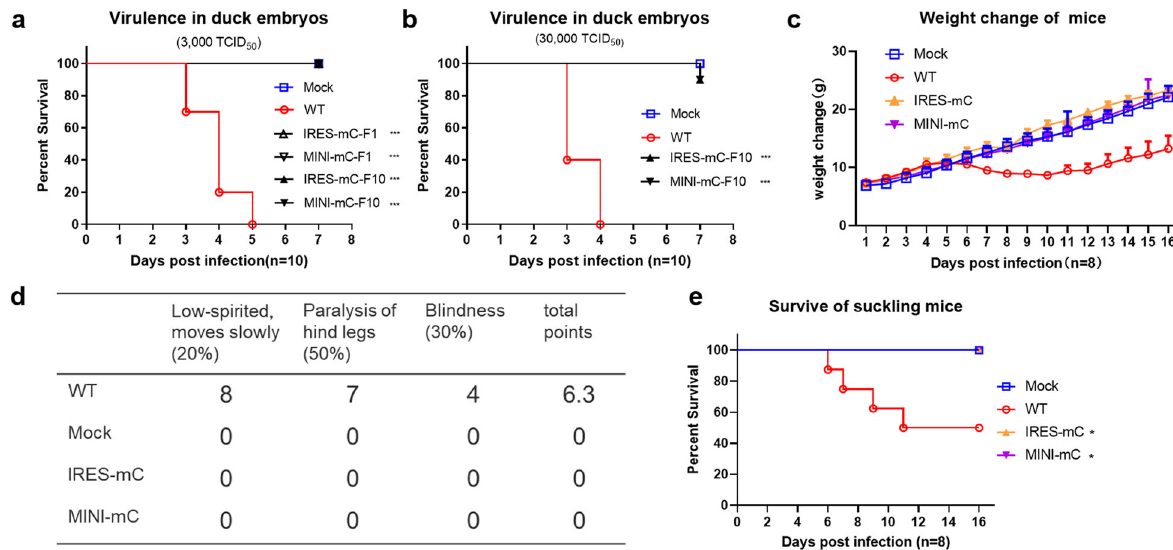
Fig. 3 In vivo virulence of CQW1-IRES-mC and CQW1-MINI-mC. Virulence of the CQW1-IRES-mC and CQW1-MINI-mC viruses in 9-day-old duck embryos ( n = 10) via allantoic cavity infection at a dose of a 3000 TCID 50 or b 30,000 TCID 50 . Neurovirulence was determined in 14-day suckling Kunming mice ( n = 8) by the intracerebral inoculation of CQW1-IRES-mC or CQW1-MINI-mC viruses at a dose of 30 µL containing 10 4.23 TCID 50 . The weight changes ( c ), clinical symptoms ( d ), and mortality ( e ) of the infected mice were then recorded. The statistical signi fi cance of the survival of the mice was analyzed using a survival curve and the log-rank (Mantel – Cox) test; signi fi cance was de fi ned by a p -value < 0.05 (* p < 0.05; ** p < 0.01; *** p < 0.001), ns indicates no signi fi